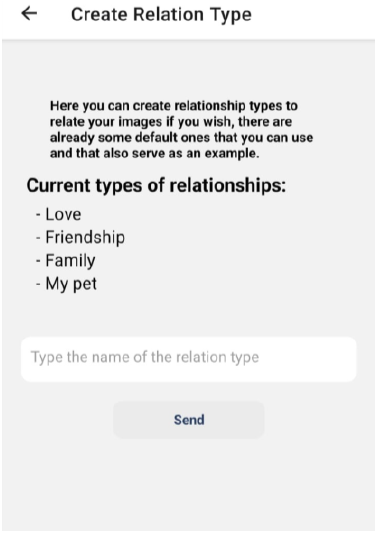
Figure 4. Create-Relation-Type screen.